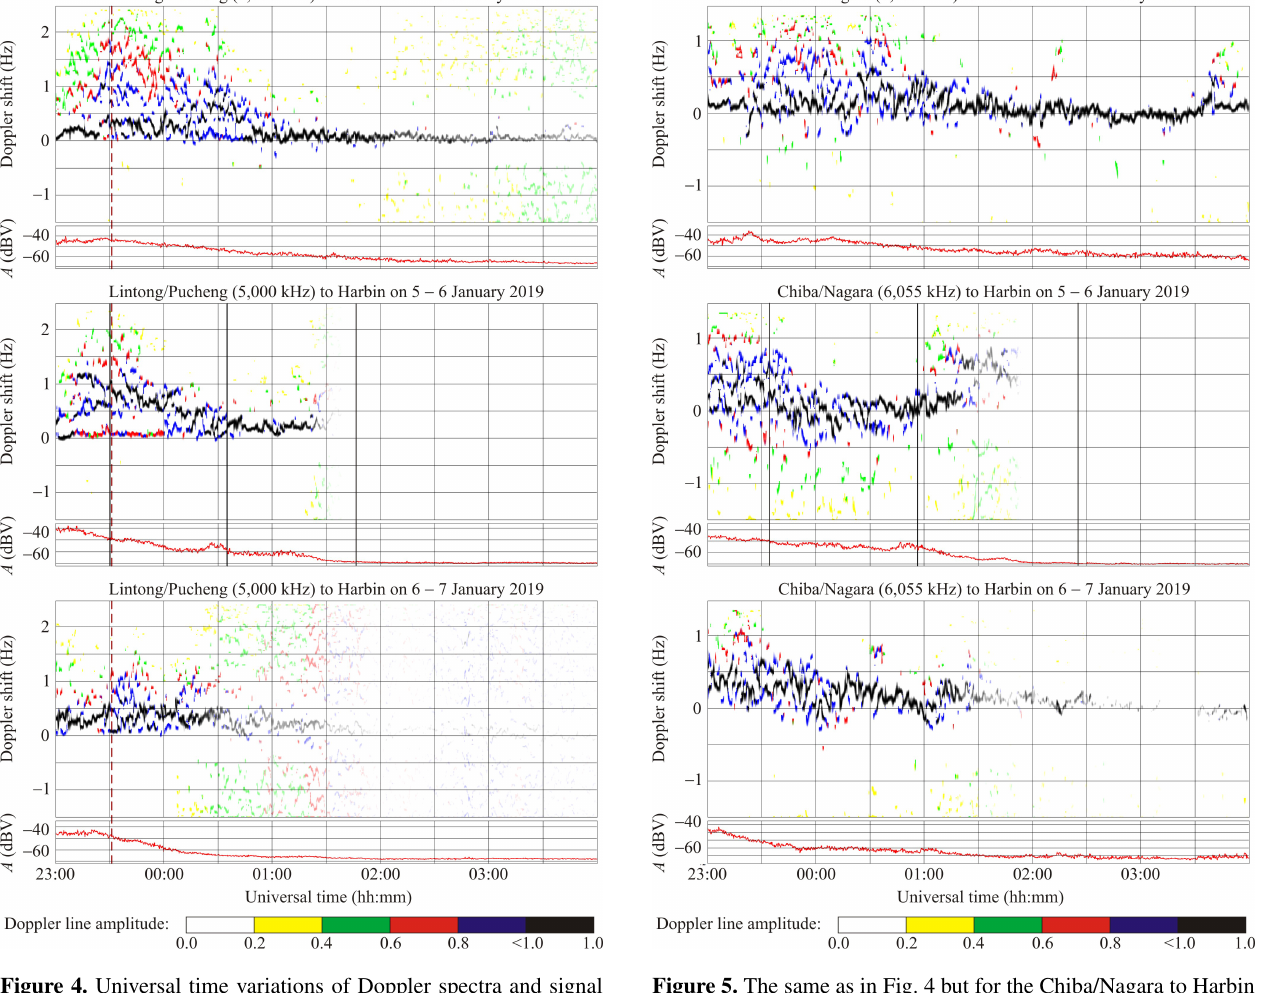
Figure 4. Universal time variations of Doppler spectra and signal amplitude ( A ) along the Lintong/Pucheng to Harbin propagation path. The black–blue–red–green–yellow colors show the relative amplitude of 1, 0.8, 0.6, 0.4, and 0.2, respectively. The vertical solid lines indicate, hereafter, the beginning, maximum phase, and the end of the solar eclipse at 100km altitude, while dashed lines indi- cate sunrise at ground level because the sunrise at 100km altitude occurred beyond the UT axis range, i.e., before 23:00UT.